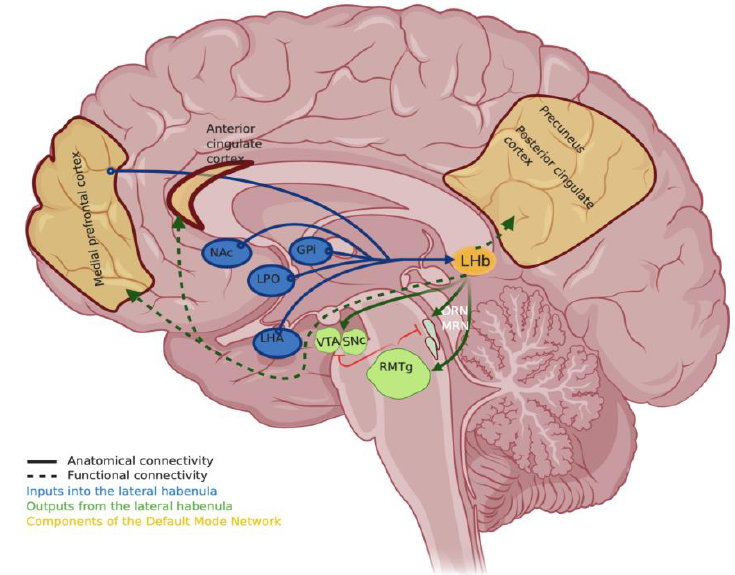
Figure 1. The cartoon shows a few major inputs (in blue) and outputs (in green) of the lateral habenula based on [11]—NAc, Nucleus Acumbmens; GPi, globus pallidus internus; LHA, lateral hypothalamic area; LPO, lateral preoptic area; MRN and DRN, medial raphe nucleus or dorsal raphe nucleus; RMTg, rostromedial tegmental nucleus; SNc, substantia nigra pars compacta; VTA, ventral tegmental area. Components of Default Mode Network (DMN, in golden) whose connectivity and gene expression profile changes by psychedelics include precuneus/posterior cingulate cortex (PCC), medial prefrontal cortex (mPFC) and the anterior cingulate cortex. The DMN cartoon is based on [42,93]. Solid lines show major anatomical connectivity described from animal and human studies, while dashed lines show functional connectivity based on recent human studies [97–99]. Created with